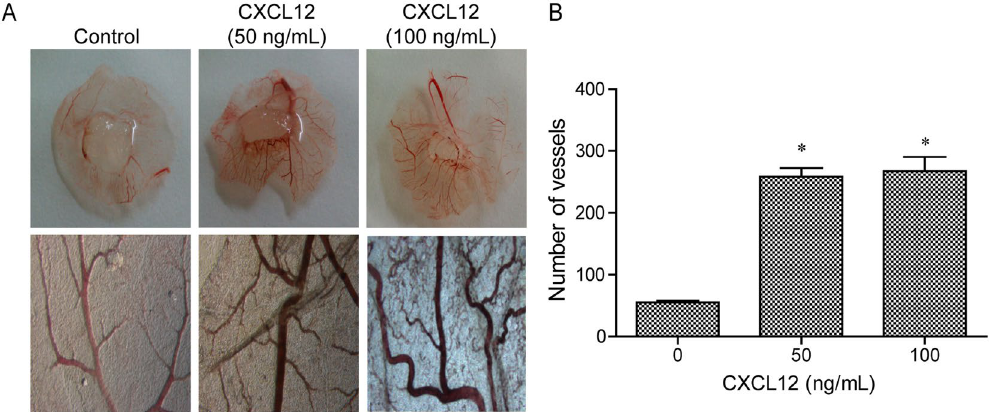
Figure 2. The CXCL12 enhances angiogenesis in chicken chorioallantoic membrane (CAM). New vessels increased with CXCL12 (0, 50 and 100 ng/mL) treatment in CAM. ( B ) Quantitative analysis of the new vessels as shown in A, mean ± SD from three independent experiments were used. * p < 0.05 versus control.